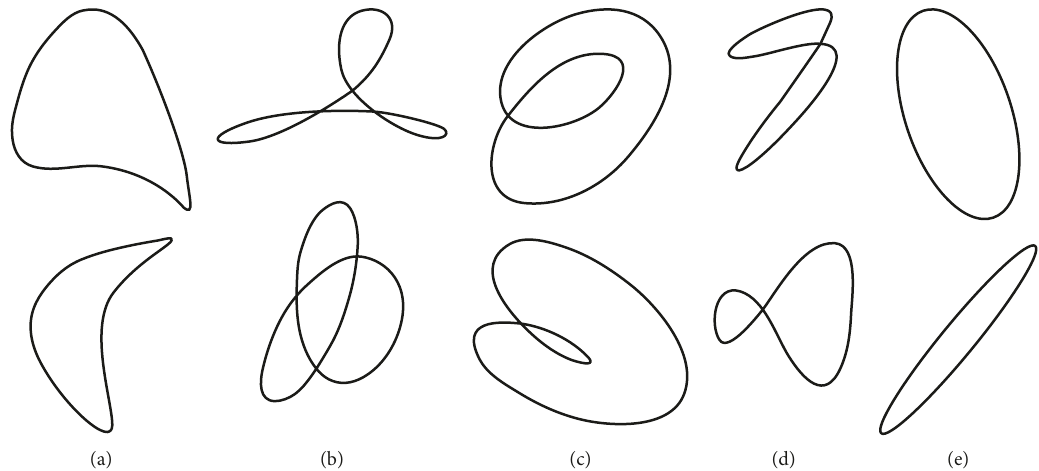
Figure 5: The typical samples of simulated shaft orbit dataset. (a) Banana-shaped; (b) petal-shaped; (c) inner “8”; (d) outer “8”; (e) ellipse.